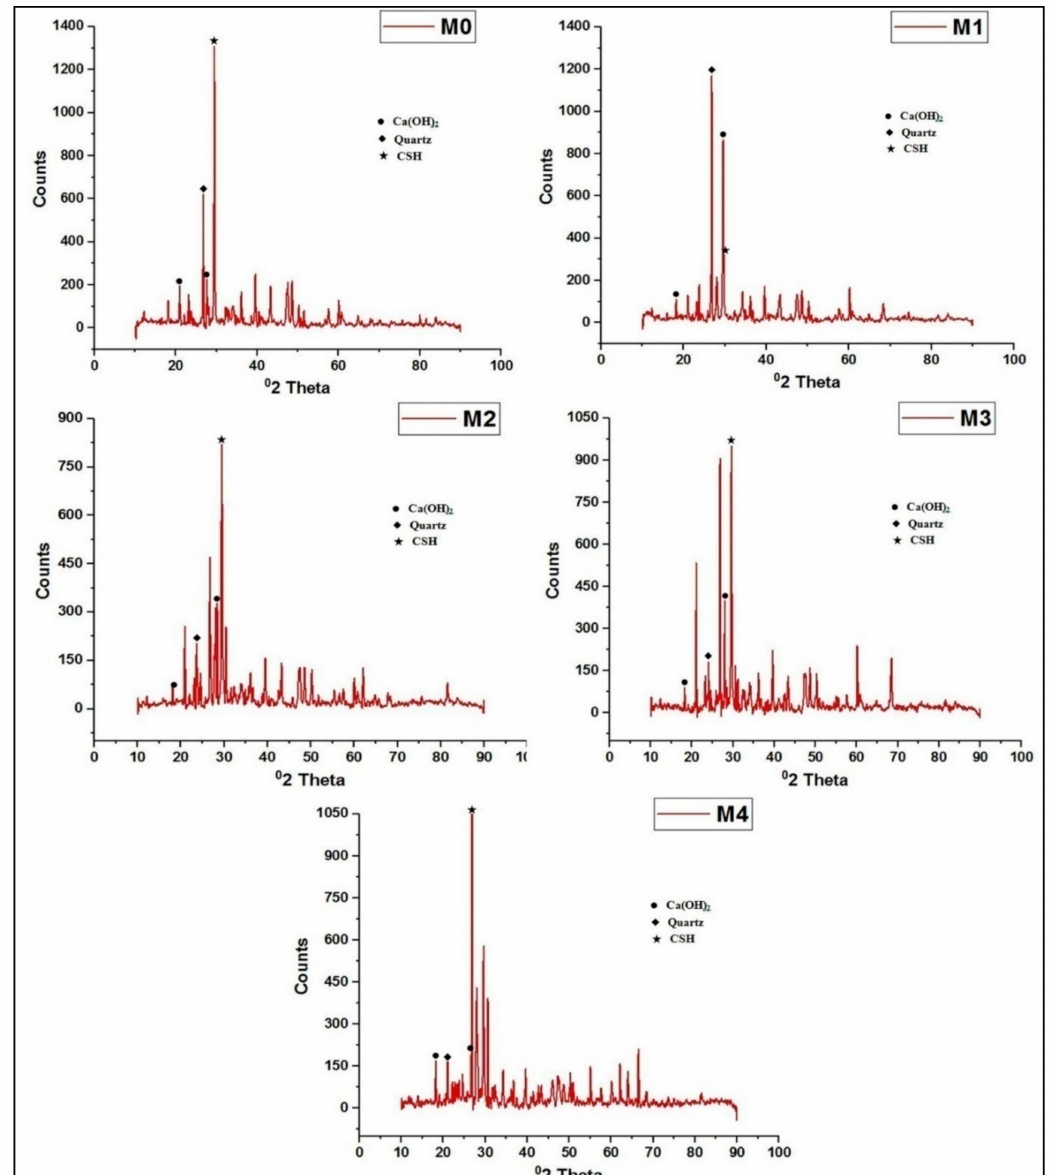
Figure 14. XRD patterns of various concrete